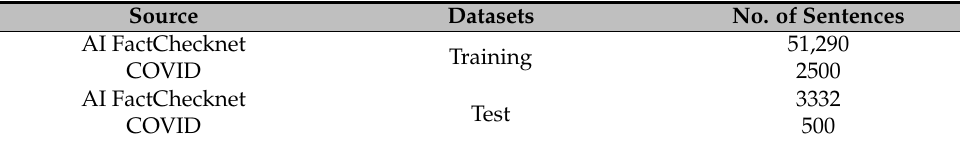
Table 2. Dataset Table 2. Dataset configurations .